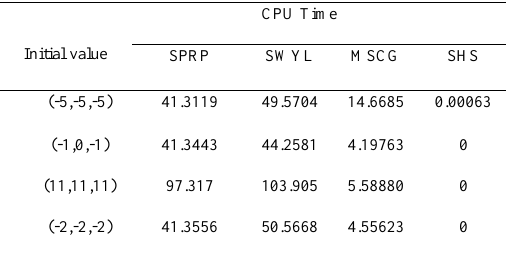
Table 2. Numerical Results for SPRP, SWYL, MSCG and SHS Methods based on CPU Time.